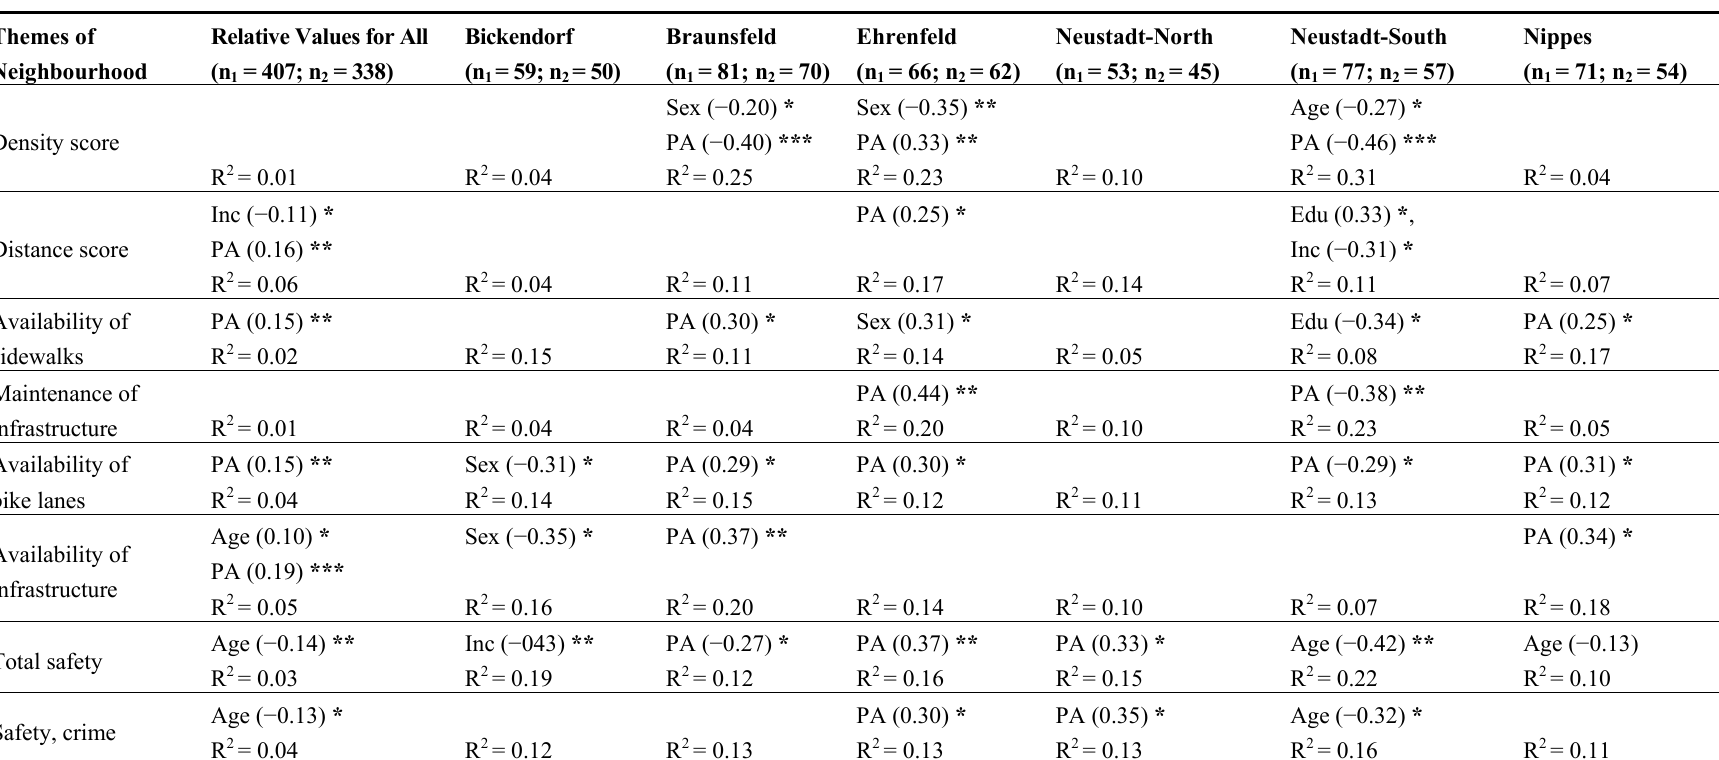
Table 6. Significant standardised β -values and all R 2 -values of multiple regression analyses of the dependent variables of environmental perception and the independent variables, transport- and recreation-related PA, as well as socio-demographic variables (sex, age, education and income) in the overall sample and in the selected city districts of Bickendorf, Braunsfeld, Ehrenfeld, Neustadt-Nord, Neustadt-Süd and